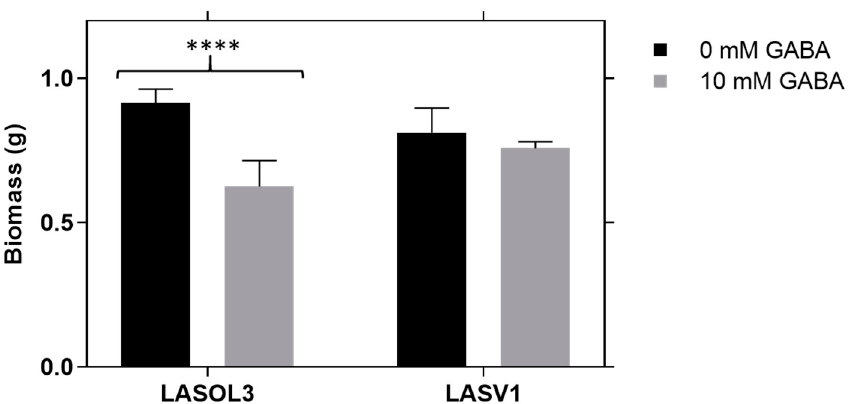
Figure 1. Effect of γ -aminobutyric acid (GABA) on the biomass of Lasiodiplodia theobromae (LA-SOL3 and LA-SV1). Data are presented as average ± standard deviation. Statistical analysis was performed using two-way ANOVA, followed by a Tukey multiple comparison test (0 mM GABA/10 mM GABA). Asterisks correspond to data, with statistical difference (**** p < 0.0001) between the same isolates; without an asterisk, there is no significant difference.